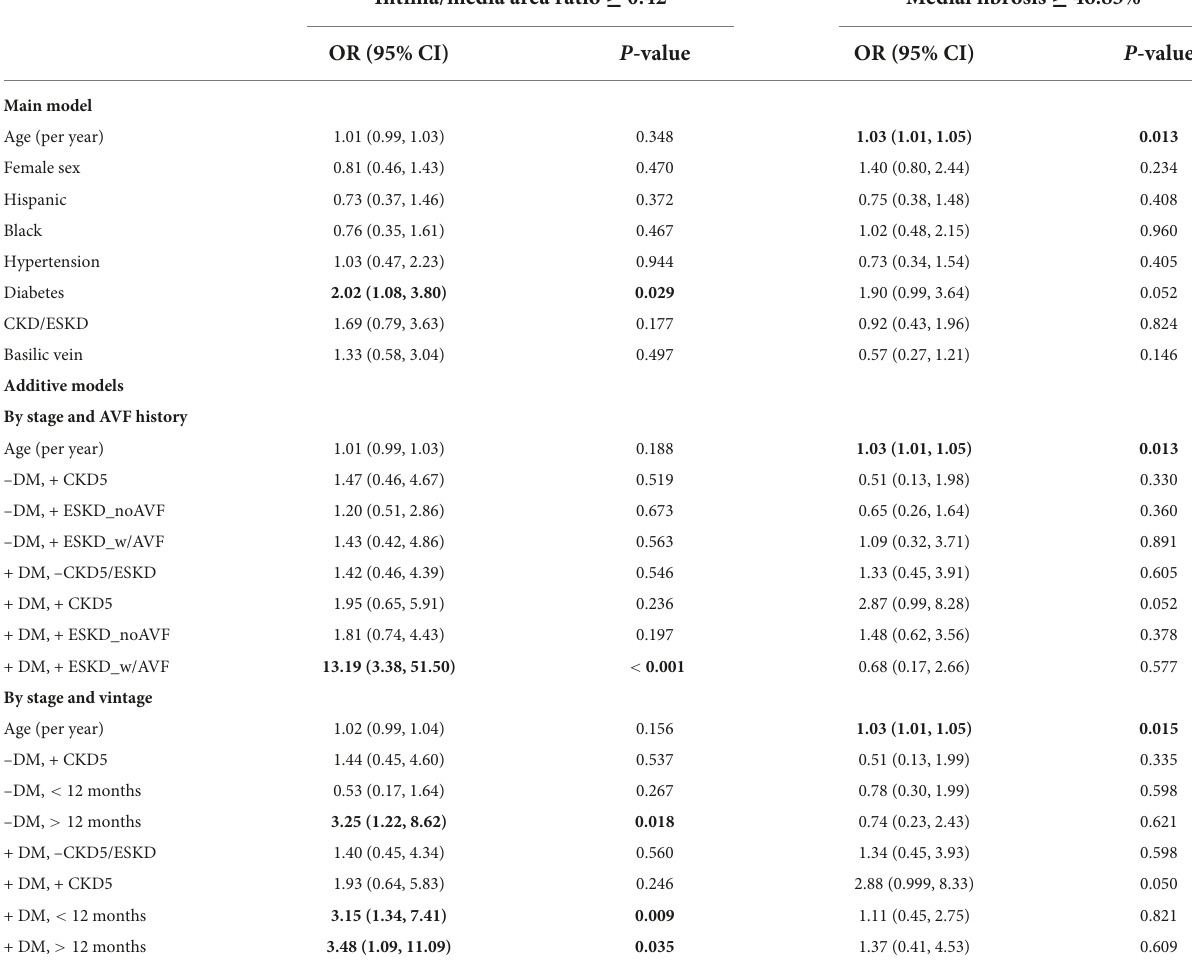
TABLE 4 Clinical predictors of upper quartile ( ≥ Q3) morphometry values using multivariate logistic regression models. Intima/media area ratio ≥